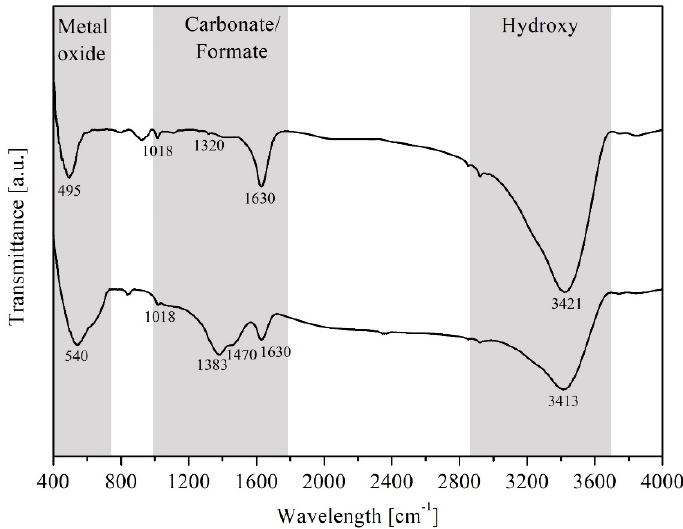
Figure 5. FTIR spectra of adsorbed gases on 40 wt% NiO/Ce 0.5 Cr 0.5 O 2 catalyst, where (top line) the fresh calcined catalyst and (below line) spent catalyst are under exposure to CO 2 + H 2 at 270 °C, both fresh and spent samples were pre-treated with hydrogen at 500 °C for 2 h and after cooling down to room temperature under Ar atmosphere.